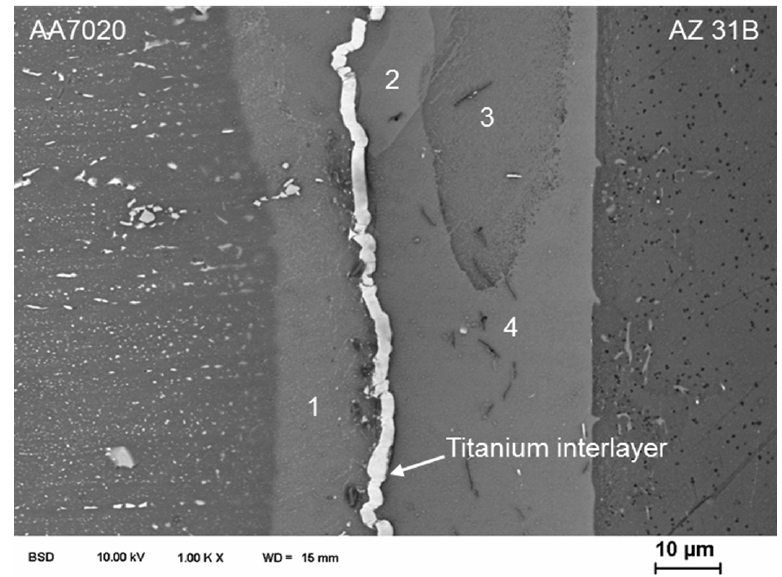
Figure 4. SEM image of the diffusion zone of Al-Mg joint consisting of ( 1 ) Al 3 Mg 2 ; ( 2 ) Al 12 Mg 17 with ca. 3 at-% Zn; ( 3 ) Al 12 Mg 17 with ca. 2 at-% Zn; and ( 4 ) Al 12 Mg 17